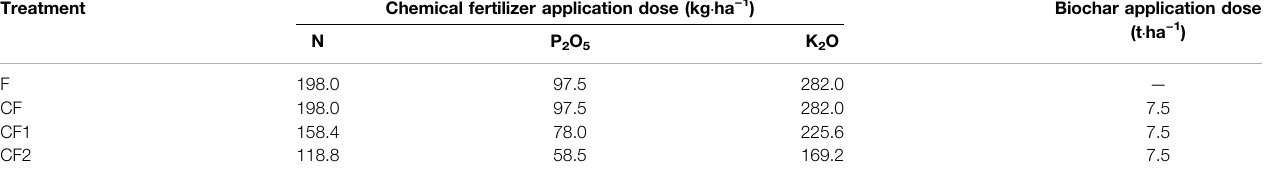
TABLE 3 | Experiment treatment.